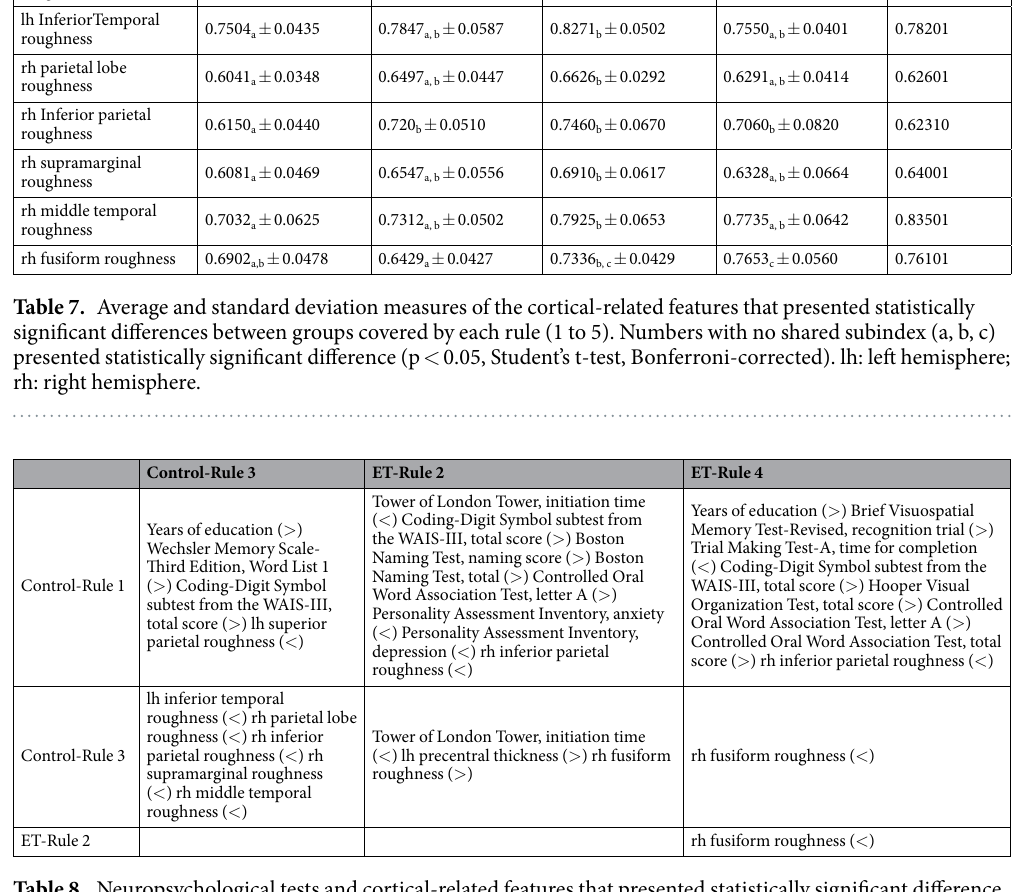
nificant volumetric differences in voxels are not necessarily of diagnostic value, since they might be over-fitted